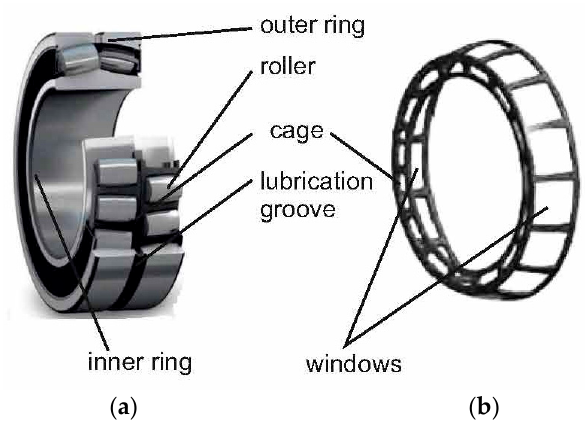
Figure 1. ( a ) Double row tapered roller bearing; ( b ) details of bearing cage.